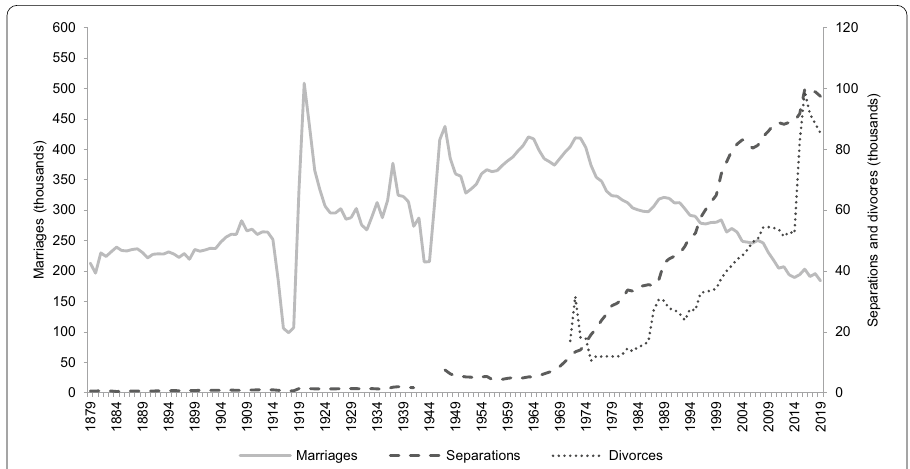
Fig. 1 Marriages (left axis) and legal separations and divorces (right axis) (in thousands), 1879–2019,